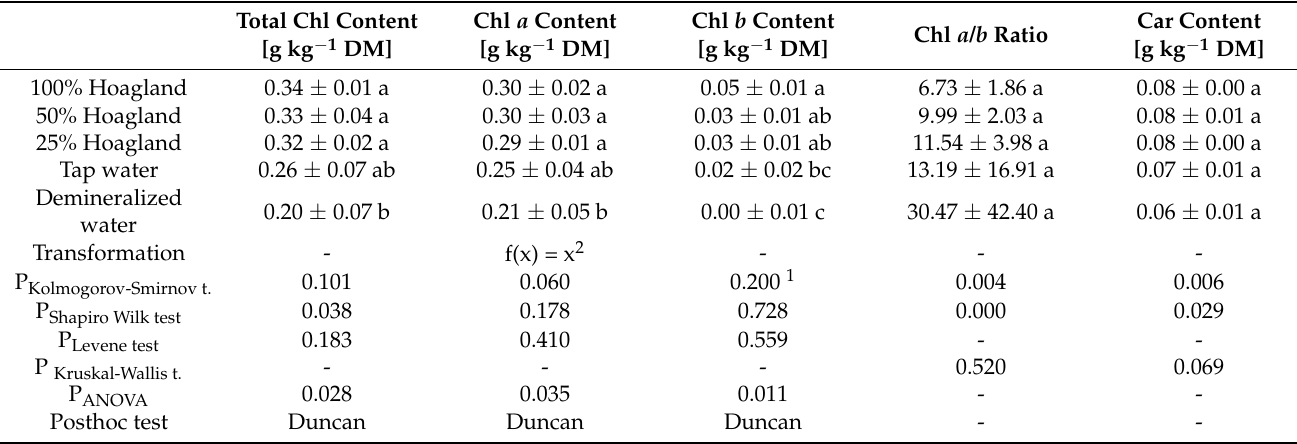
Table 8. Content of pigments in the stems of radish cress in g kg − 1 dry mass (DM). Different letters within a column indicate significant differences.